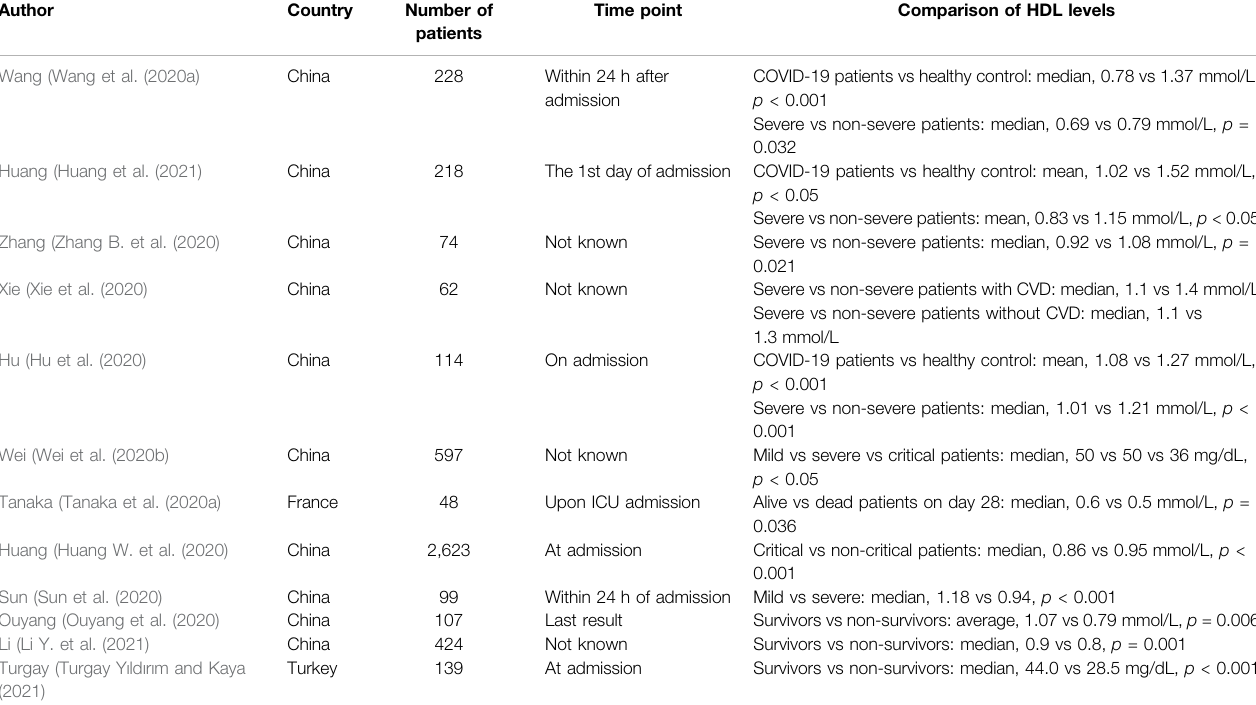
TABLE 1 | Changes in HDL levels in patients with